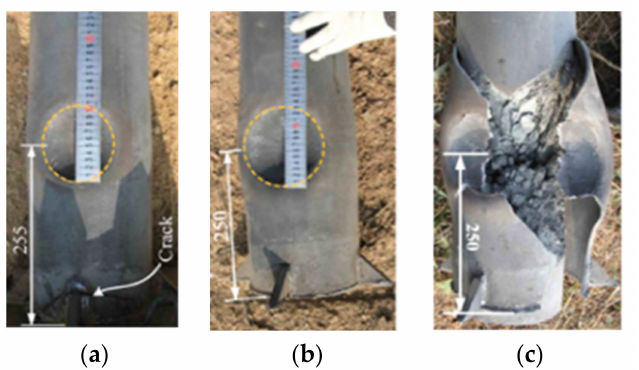
Figure 7. Damage of UHPCC-FST columns after detonation of: ( a ) 1 kg; ( b ) 2 kg and ( c ) 3 kg of TNT [29]. Copyright permission obtained from authors.